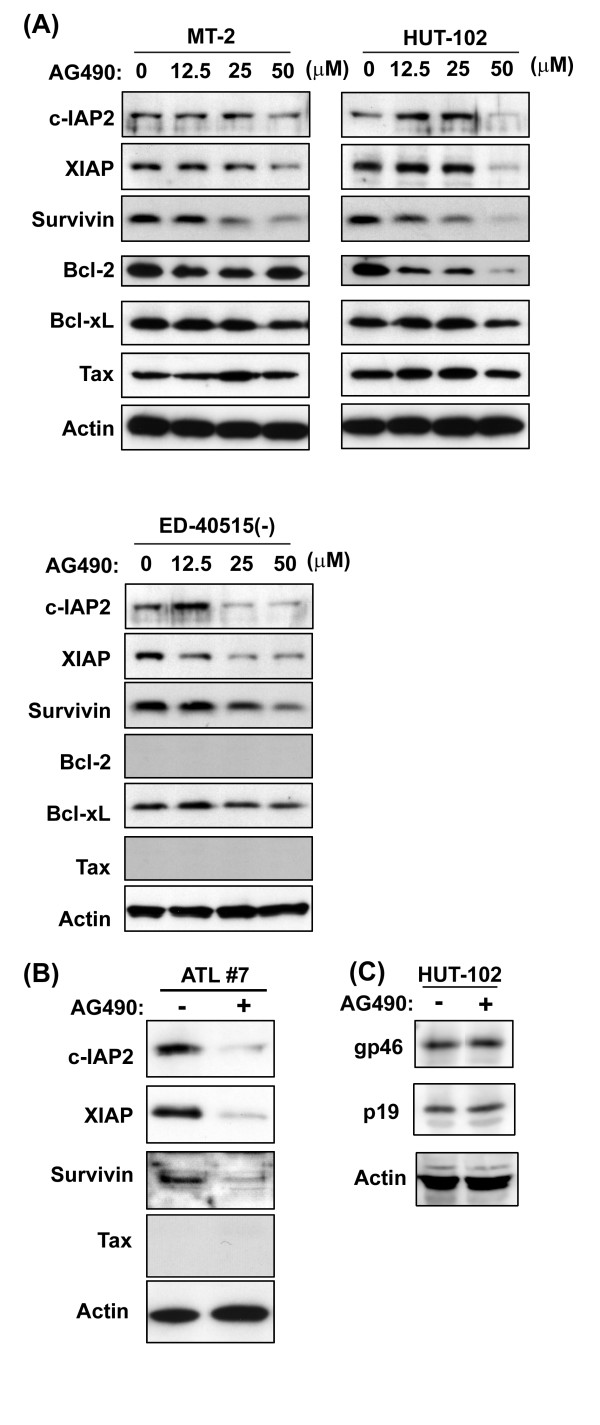
Effects of AG490 on the expression of anti-apoptotic proteins. (A) HTLV-1-infected T-cell lines were treated with increasing concentrations of AG490 for 24 h. Amounts of c-IAP-2, XIAP, survivin, Bcl-2, Bcl-xL and Tax were determined by Western blot analysis. (B) Primary ATL cells were treated with (+) or without (-) 50 μM AG490 for 24 h. The expression of c-IAP2, XIAP, survivin and Tax was assessed by Western blot analysis. (C) HUT-102 cells were treated with (+) or without (-) 50 μM AG490 for 24 h. The expression of HTLV-1 viral proteins, envelope glycoprotein gp46 and p19 core protein was assessed by Western blot analysis. The amount of actin is shown as a loading control.